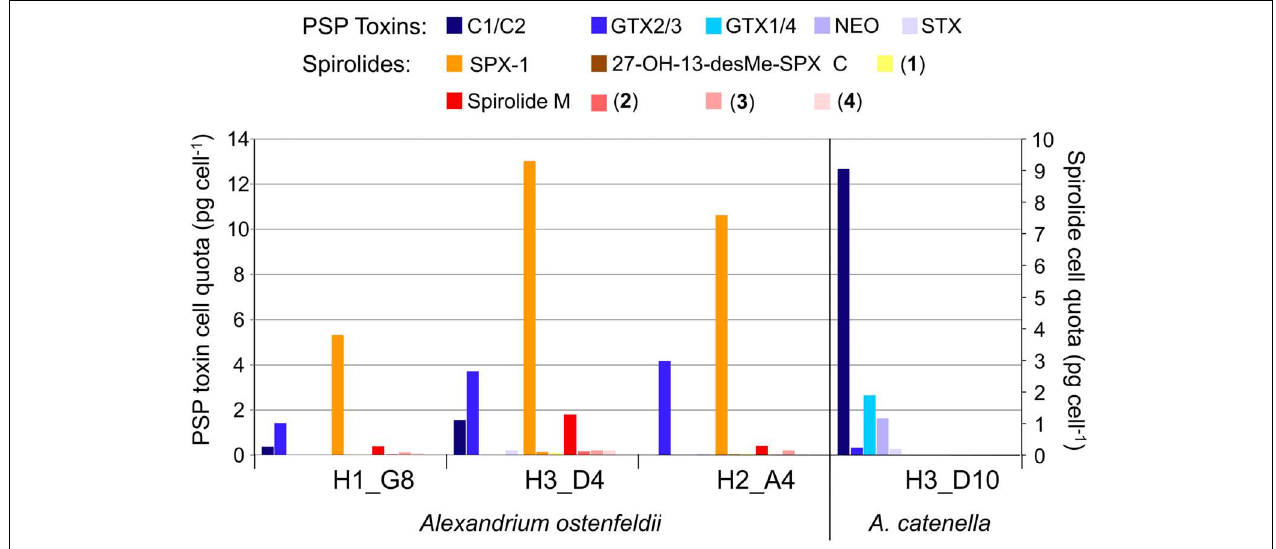
FIGURE 11 | Profiles of the toxin of four Alexandrium